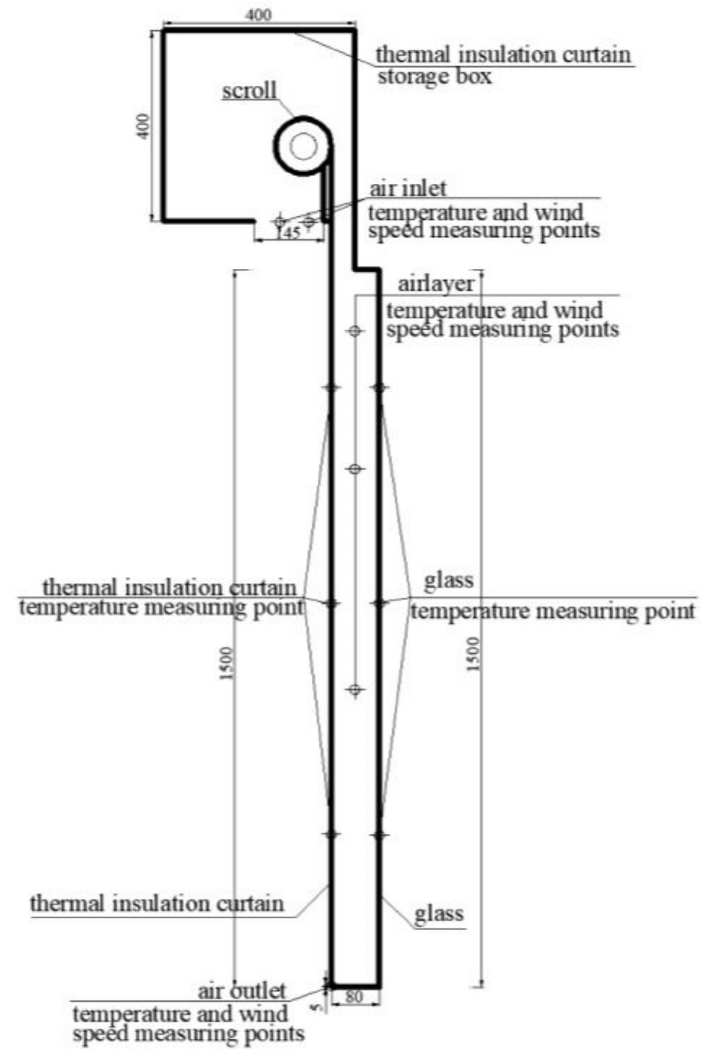
Figure 1. Experimental determination of the layout. The thermal insulation curtain device is composed of a curtain, a curtain storage box, and a curtain guide rail. The curtain is filled with a 2 cm thick polyurethane aluminum alloy shell connected to each